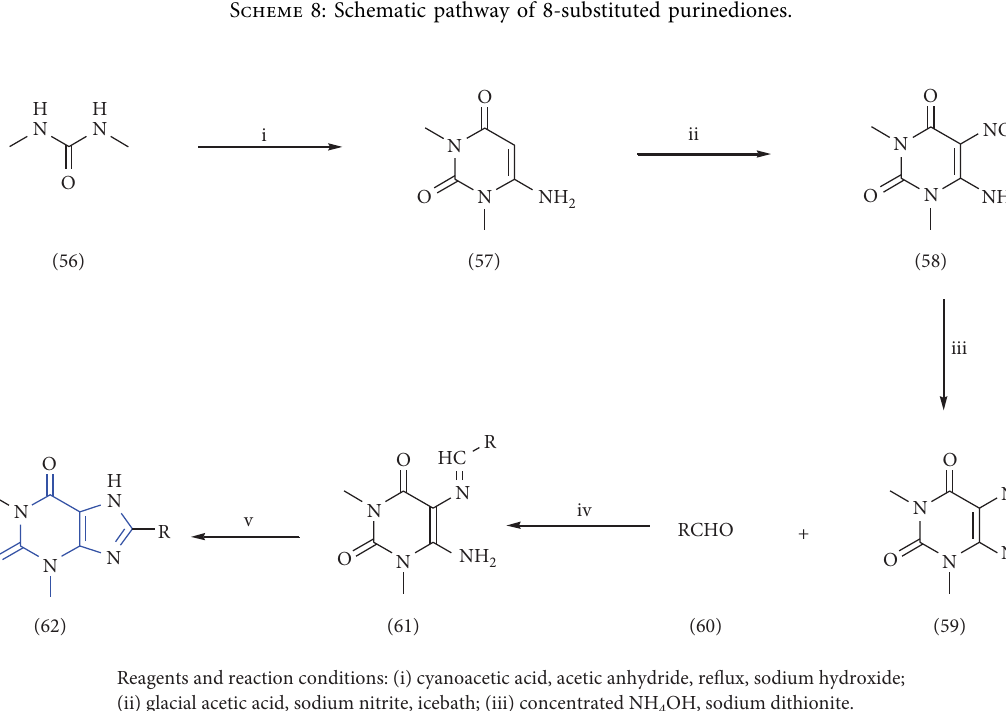
Scheme 8: Schematic pathway of 8-substituted purinediones.